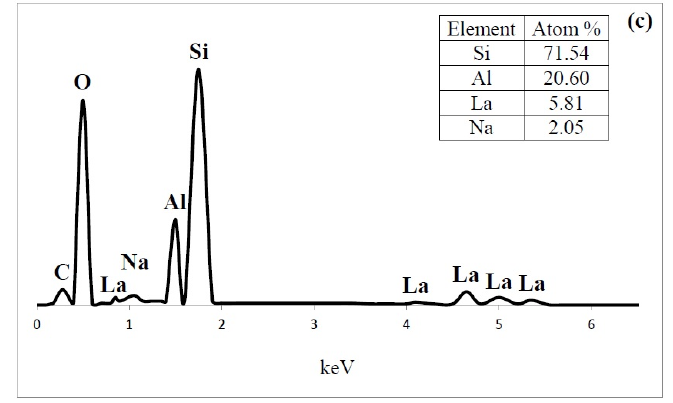
Figure 9. Energy-dispersive X-ray spectroscopy (EDS) spectrum content of ( a ) HY; ( b ) LaY and ( c ) Pd/LaY catalysts.